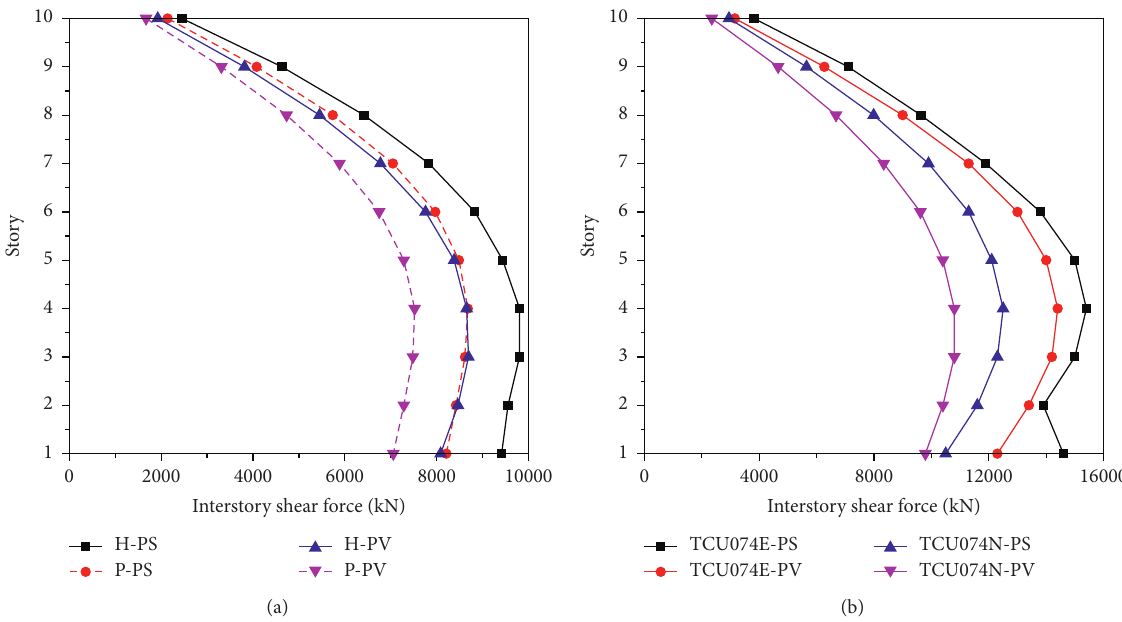
Figure 21: (a) The average peak interstory shear force of the structure under the horizontal component and parallel component of near-fault ground motion; (b) the peak interstory shear force of the structure under the ground motion of